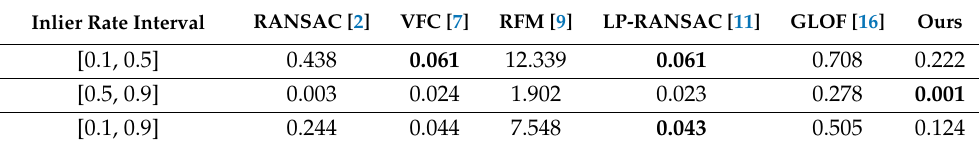
Table 6. Average execution time (in seconds) comparison for the “University Campus” dataset. Inlier Rate